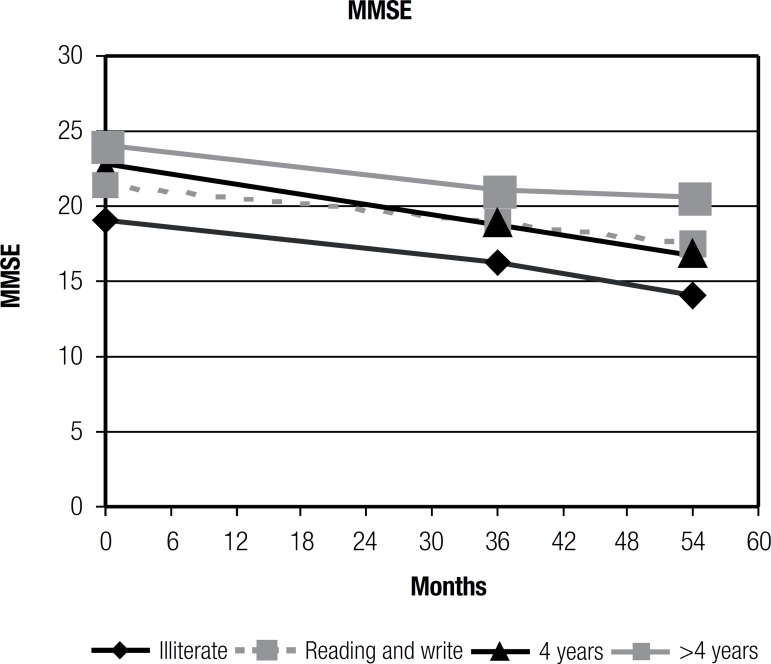
Patterns of MMSE obtained for different educational levels.